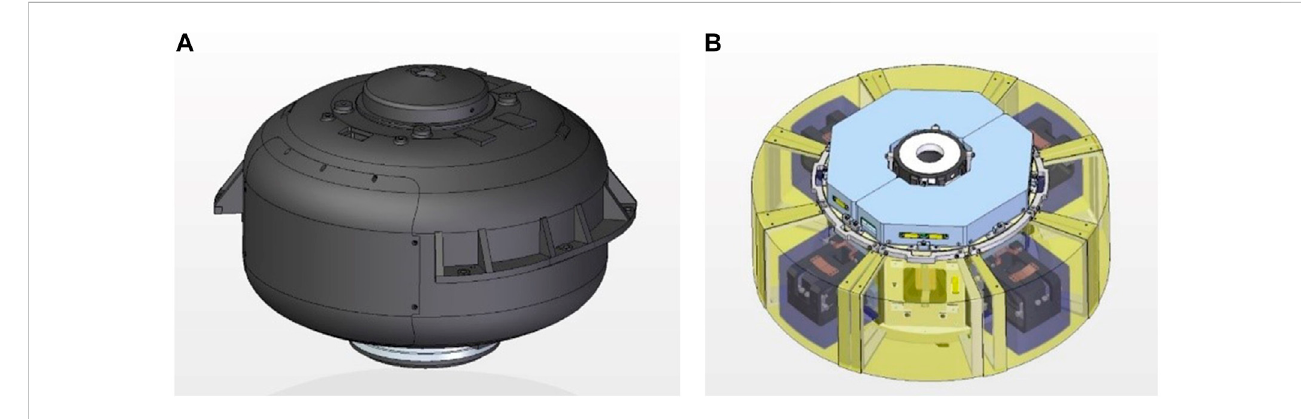
FIGURE 2 GGI (A) and rotating body parts (B)